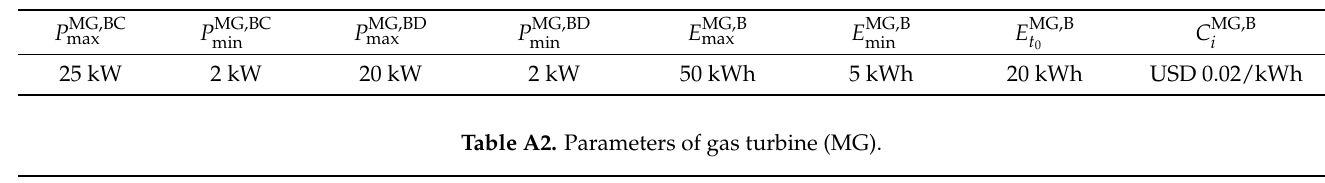
Table A1. Parameters of energy storage system (MG).